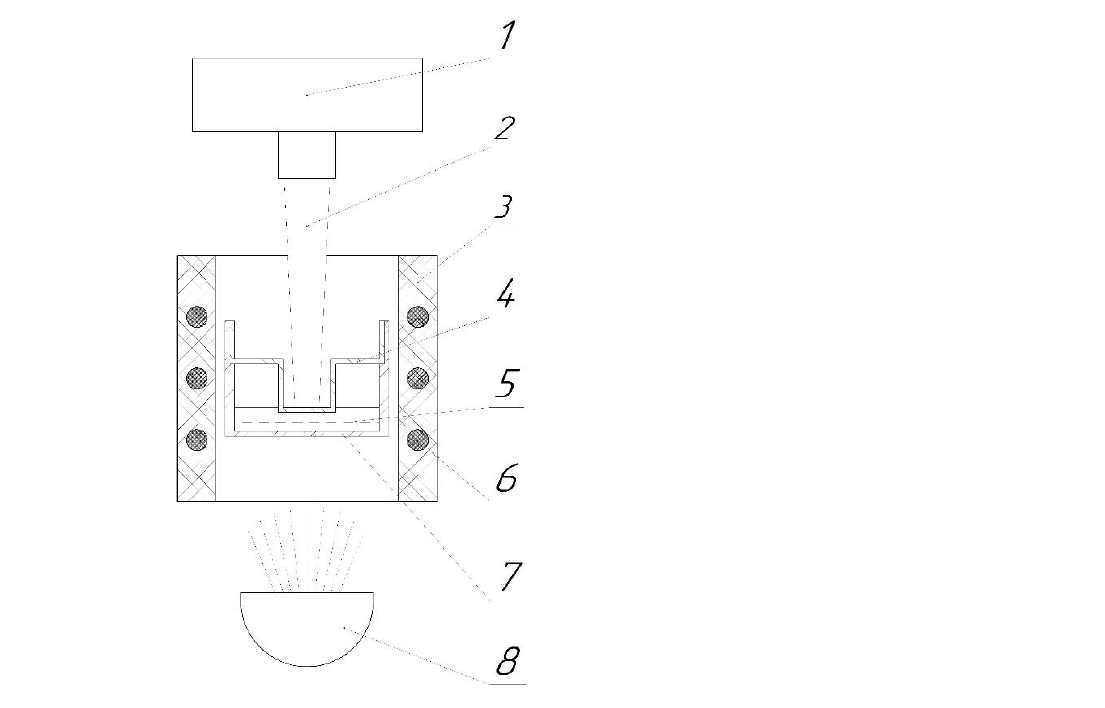
Figure 2. Measuring cell scheme for the laser flash method: 1 — IR Detector; 2 — IR Beam; 3 — Furnace; 4 — Lid; 5 — Sample; 6 — Heater; 7 — Crucible; 8 — Halogen Lamp.